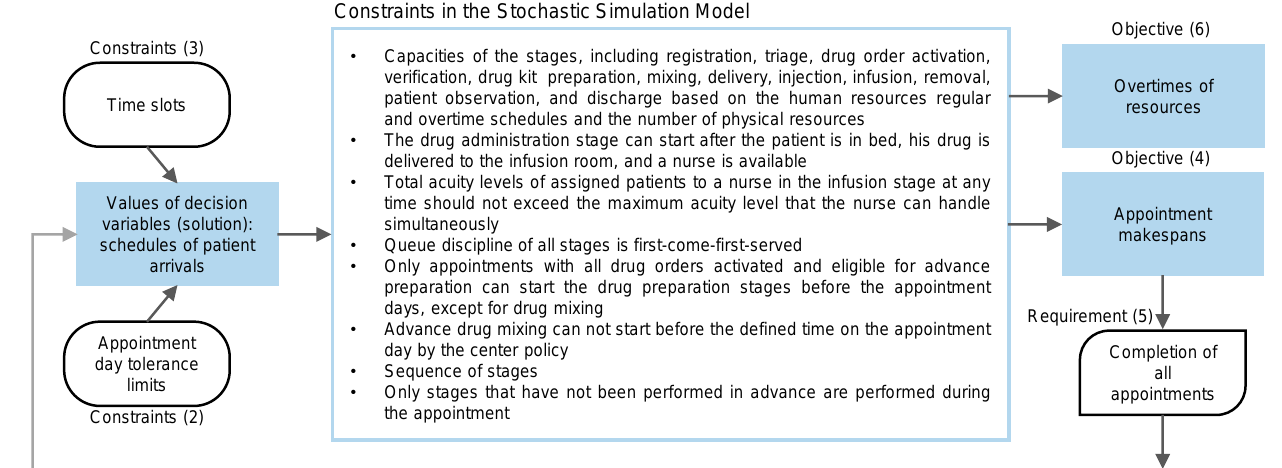
Figure 2. Formulation of the studied OCA